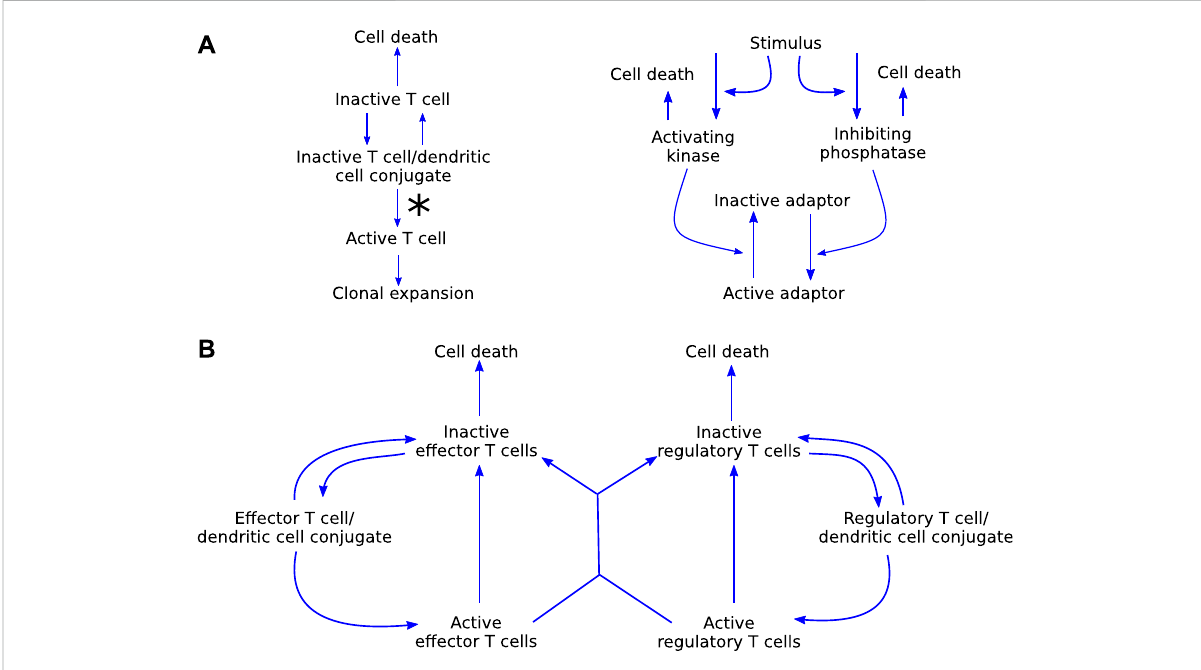
FIGURE 5 (A) graphical representation of model (i) by Carneiro et al. (2005), which explores the hypothesis that self-tolerance is maintained through a T cell activation threshold. The molecular dynamics on the right, speci fi cally the ratio of kinase to phosphatase, in fl uence the rate at which T cells leave the conjugate in an activated state, signi fi edby the asteriks on the left. (B) Graphical representation of model (ii) by Carneiro et al. (2005) which explores the hypothesis that regulatory T cells are responsible for maintaining self-tolerance. Blue arrow-heads indicate stimulation.